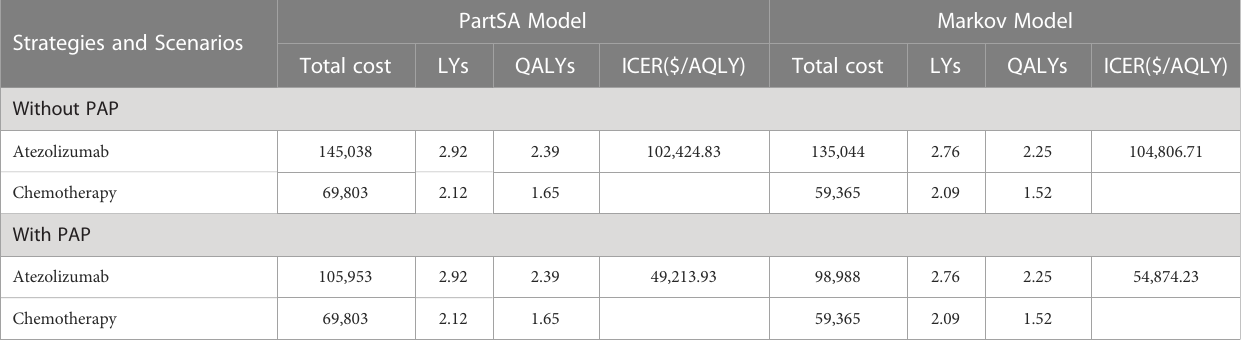
TABLE 3 Base-case